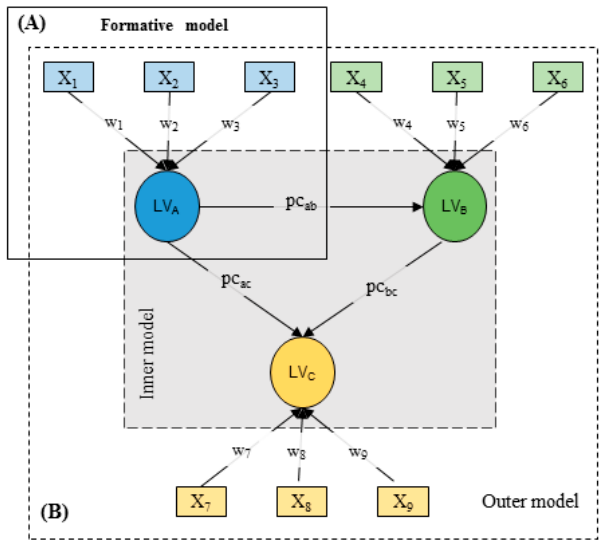
Figure 4. Schematic representation of partial least squares-path modelling (PLS-PM): ( a ) panel that illustrates the formative model; ( b ) panel that illustrates the relationships (inner model) between latent variables (LV) and the links (outer model), between the LV and the measured values (MV). The strength of those relationships is represented by path coefficients (pc) and weights (w) computed by the PLS-PM model.